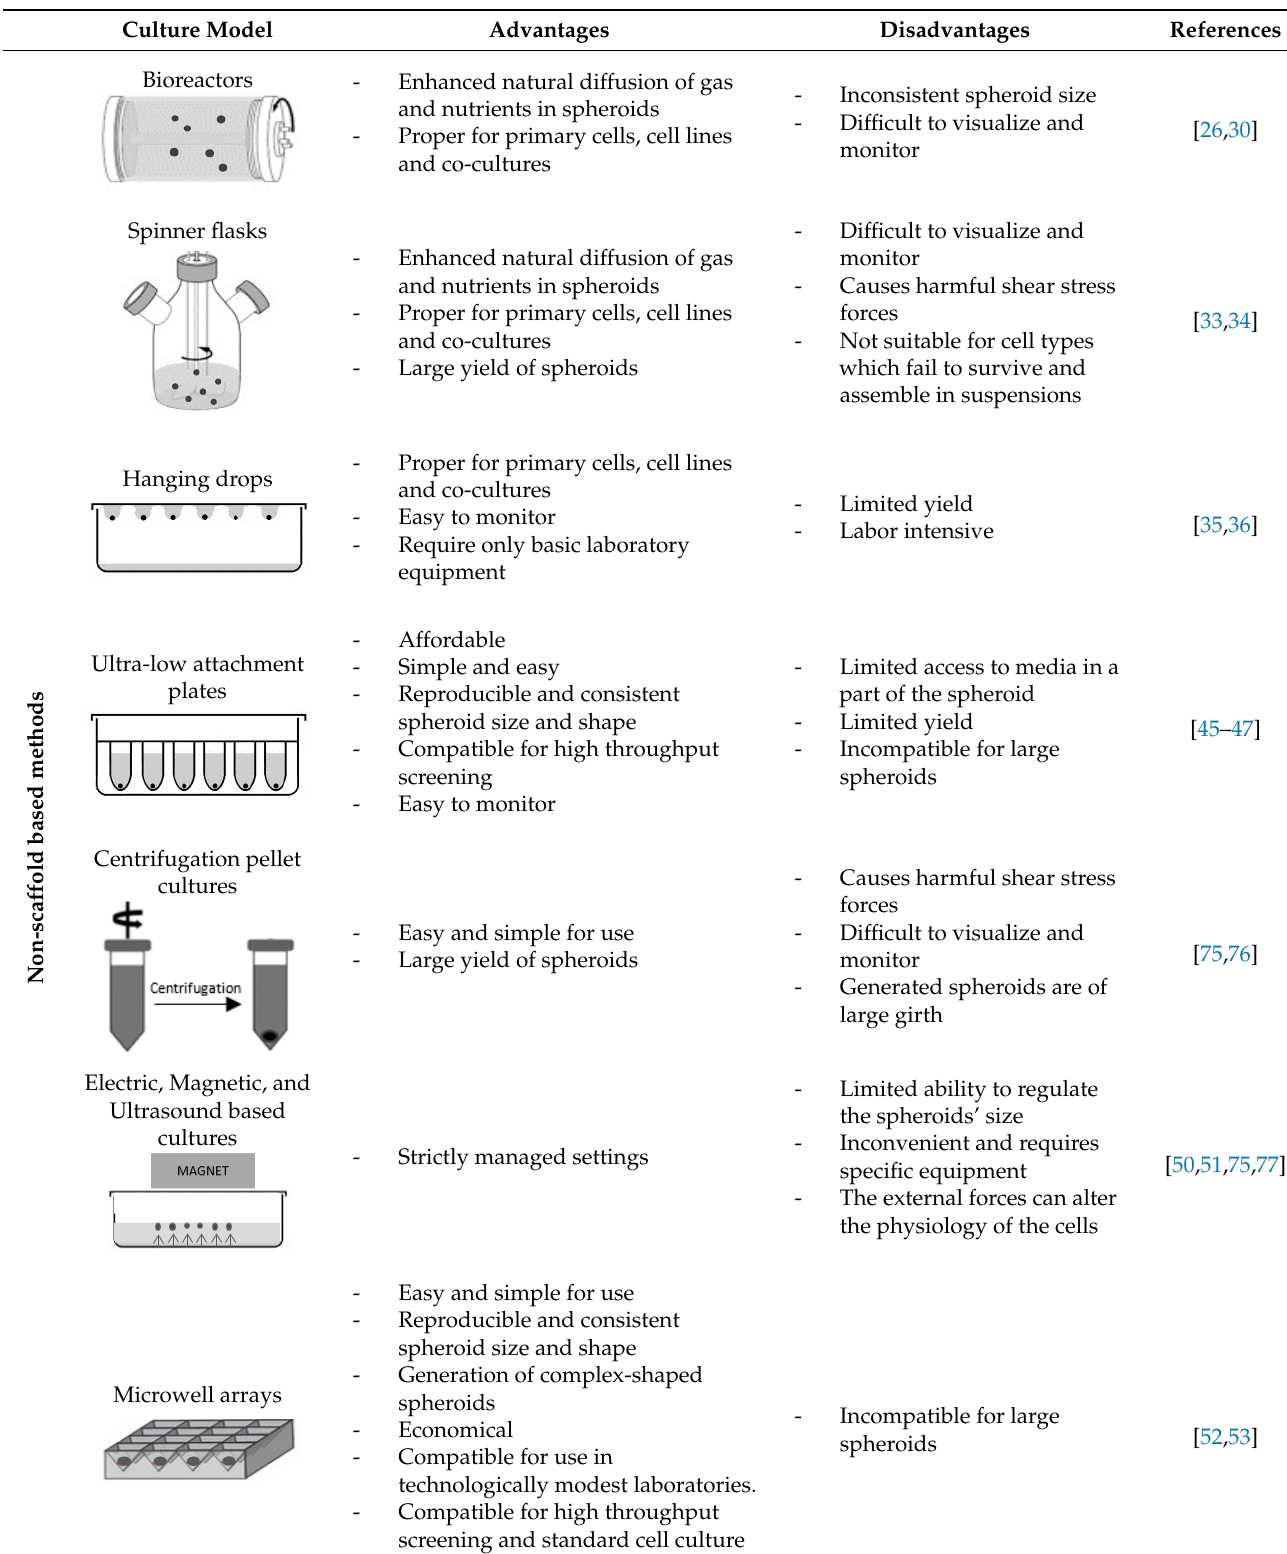
Table 1. Three-dimensional spheroid-generating systems. Culture Model